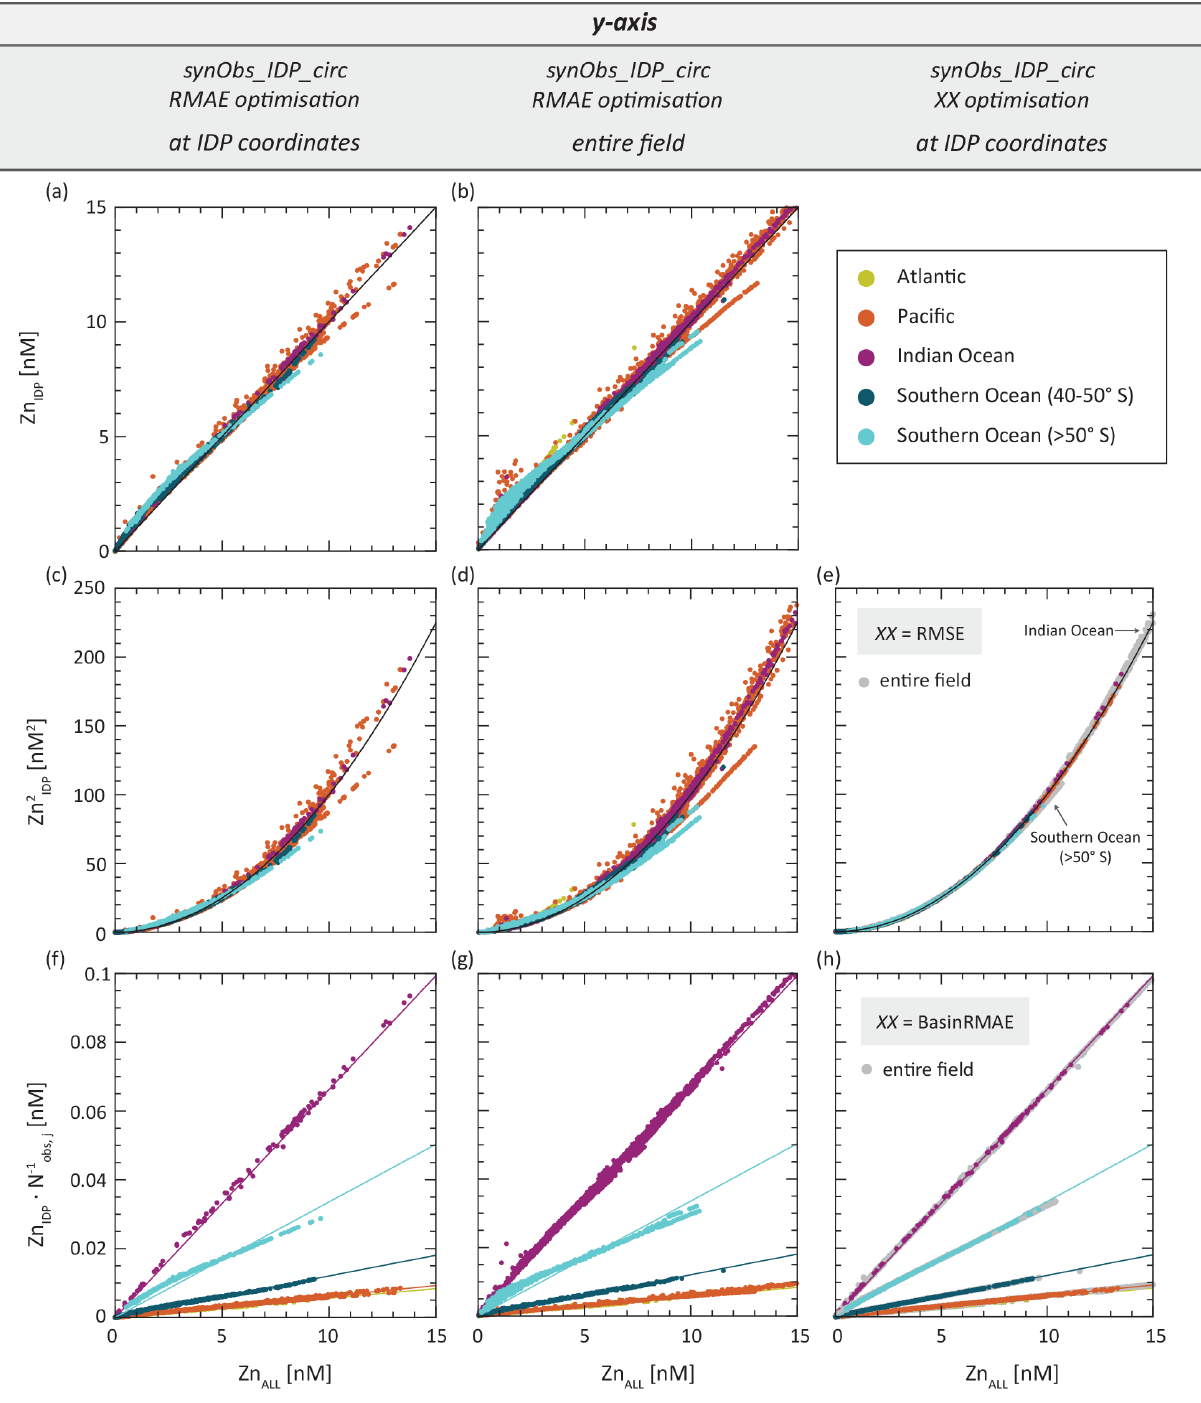
https://doi.org/10.5194/bg-19-5079-2022 Biogeosciences, 19, 5079–5106,